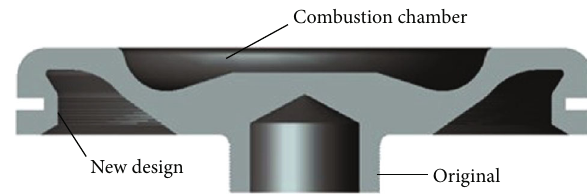
Figure 12: Two schemes for thread